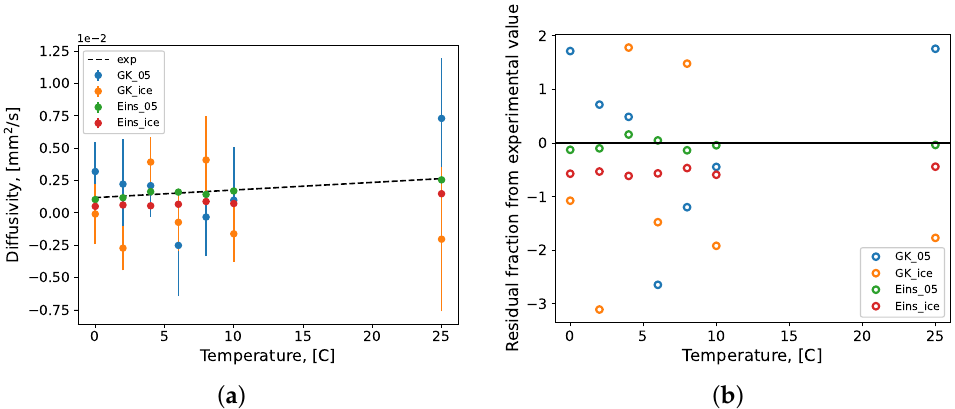
Figure 6. The ( a ) diffusivity of pure water systems and ( b ) fractional residual difference between MD prediction and experimental value. Repeated simulation produced samples of each condition’s prediction value of size n = 10; theses samples were bootstrapped with replacement ( n = 10,000) to calculate mean values which are presented here with their standard error bars. GK: Green–Kubo formulation; Eins: Einstein formulation; 05: TIP4P/200; ice: TIP4P/Ice; exp: linear regression of experimental data